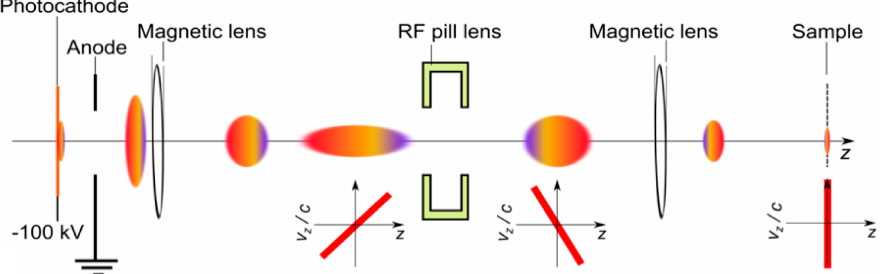
Figure 18. Layout of a hybrid DF-RF FED setup. The electron bunch is represented by a colored gradient where faster electrons are in violet and slower electrons in red. The electron pulse is generated via the photoelectric effect. This part is essentially the same as in a compact DC electron gun. The longitudinal momentum-space distributions within the electron bunch are illustrated below. The effect of the axial RF electric field is to invert the longitudinal momentum–space distribution causing the electron bunch to recompress during its propagation towards the sample, which is located at the temporal focal point. Magnetic lenses (MLs) are used to control the transverse dimension of the electron beam. Figure adapted from Reference [4] with permission from IOP